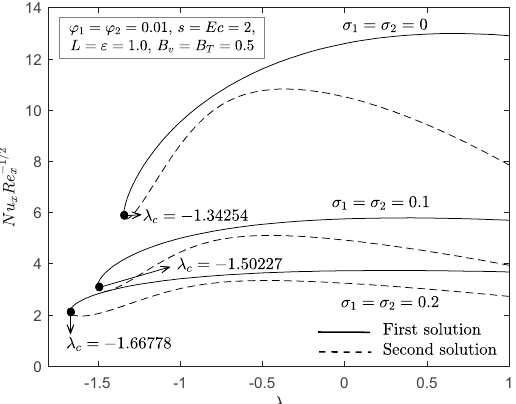
Figure 9. with λ for various slip parameters Figure 9. Nu x Re − 1/2 x with λ for various slip parameters.